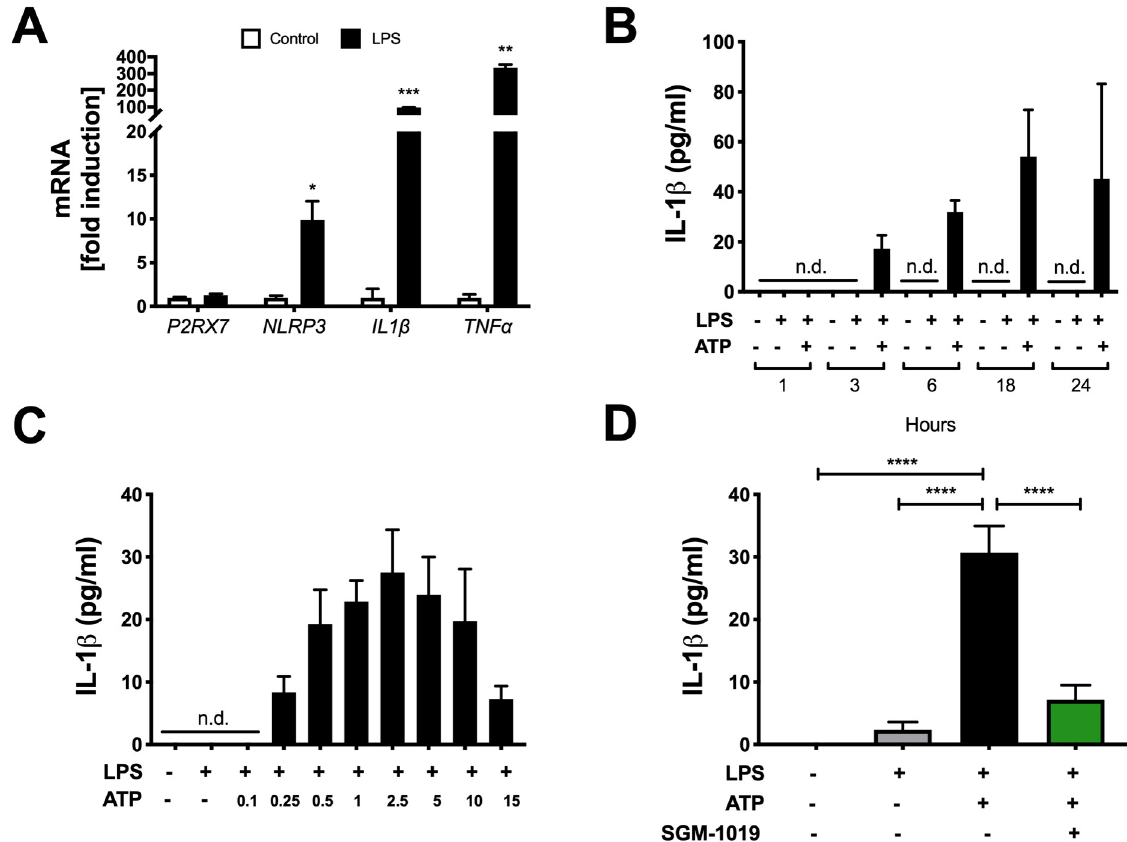
Fig 4. Inhibition of P2RX7 blocks IL-1 β -induced inflammasome activation in KCs. (A) Relative expression of P2RX 7, NLRP3 , IL-1 β , and and TNF α in KCs treated with LPS for 1 hour. (B) IL-1 β levels in culture media from KCs pretreated at different times of LPS stimulation with and without ATP. (C) IL-1 β levels in culture media from KCs pretreated with LPS and stimulated with increasing doses of ATP. (D) IL-1 β levels in culture media from KCs treated with LPS, ATP ± SGM-1019. n.d., for not detected. In all statistical plots, the data are shown as the mean ± SEM. � P � 0.05, �� P � 0.01, ��� P � 0.001, ���� P � 0.0001 by one-way ANOVA.